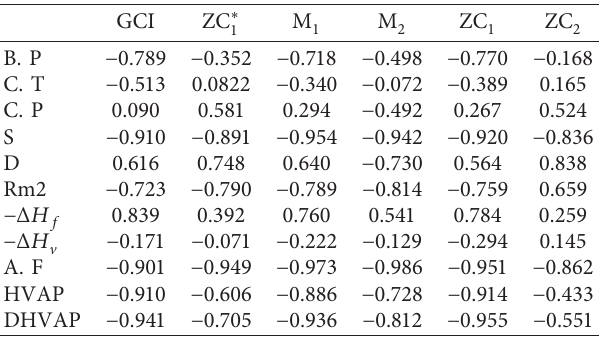
Table 1: Comparison of correlation coefficients between TIs and physicochemical properties of octane